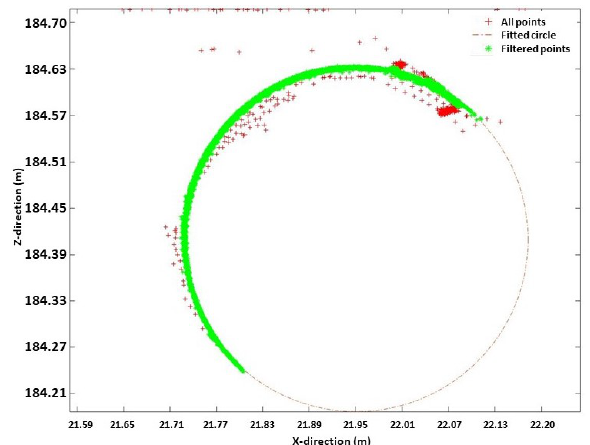
Figure 13. Laser points of one roller containing the roller points, outlier points, and the fitted circle.